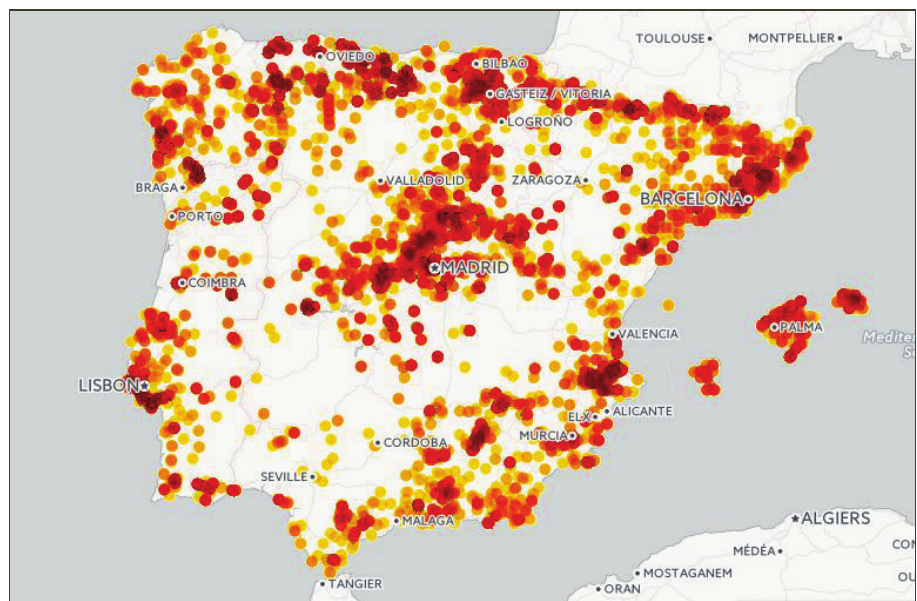
Figure 3. Geographic distribution of the georeferenced records. The darker the color, the higher is the record density.